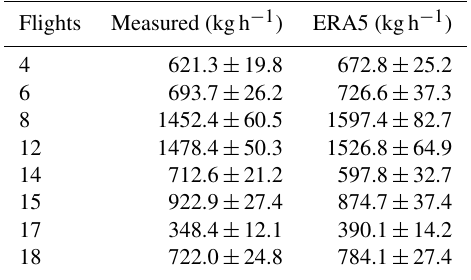
Table 3. Parameters retrieved by GA-IPPF through the ERA5